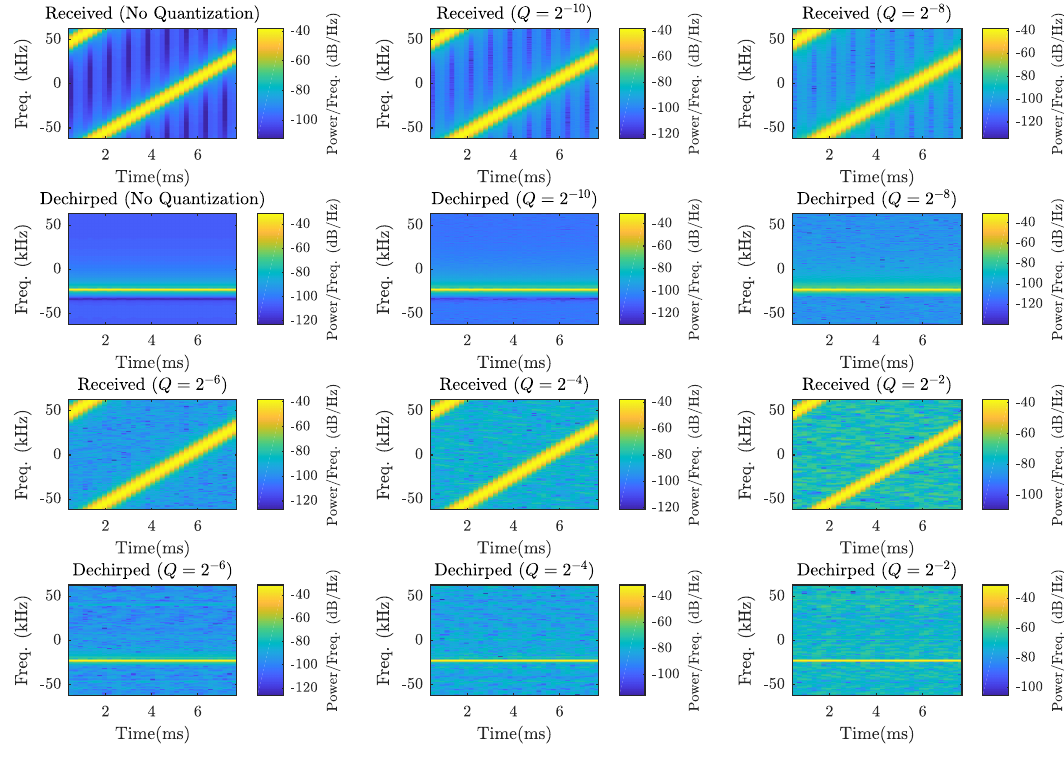
Figure 4. Fast Fourier transform (FFT) and spectrograms for filtered modulated chirps with and without quantization when SF = 10, BW = 125 kHz, and m =